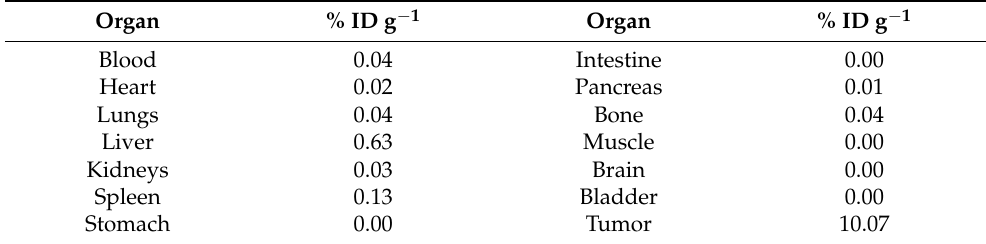
Table 1. Biodistribution of 198 AuNP 21 days after intratumoral injection in a Balb/c nude mouse bearing the PC-3 tumor.